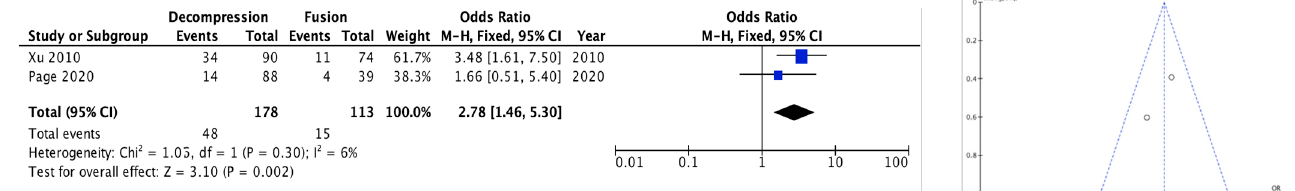
Figure A10. Post-op back pain.